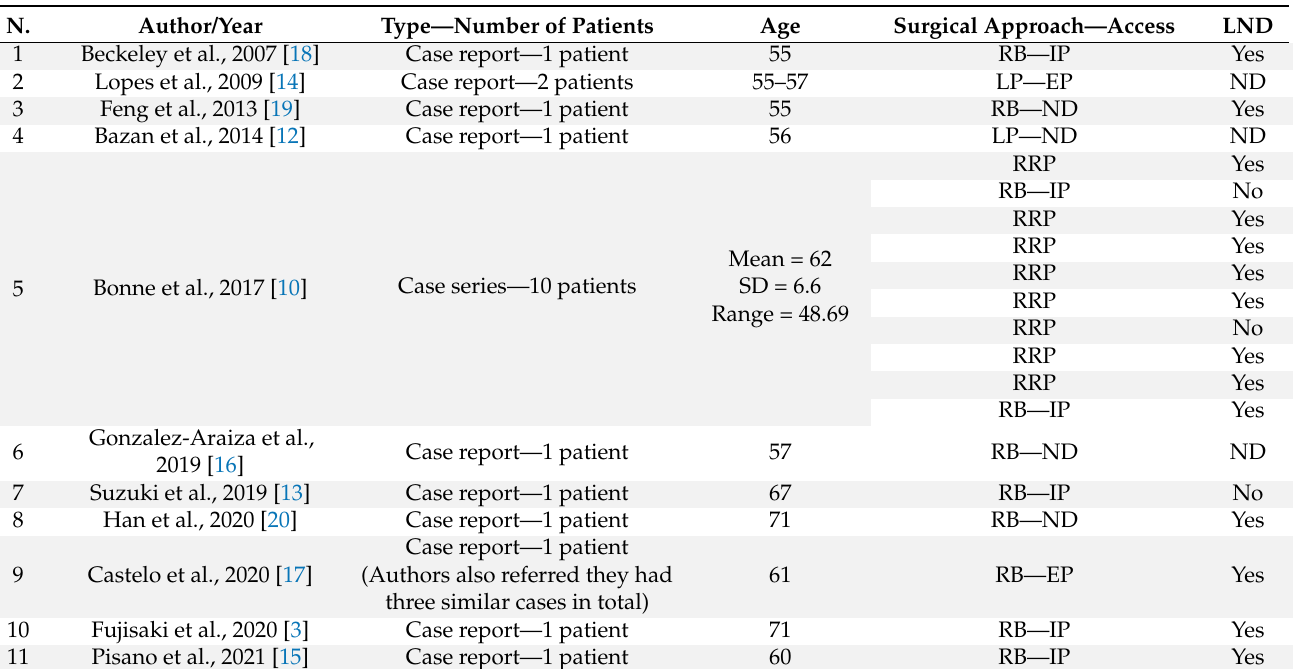
Table 1. Summary of the works reviewed. General data of the patients described: age, type of surgical procedure, lymphadenectomy (LND). RB = robotic; IP = intraperitoneal; EP = extraperitoneal; LP = laparoscopic; RRP = radical retropubic prostatectomy; ND = not